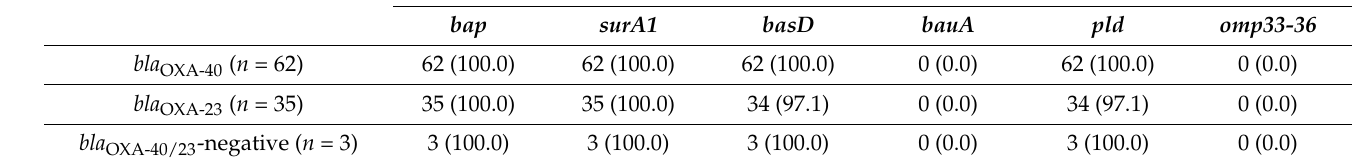
Table 5. The occurrence of virulence factor genes among A. baumannii strains included in the study ( n =